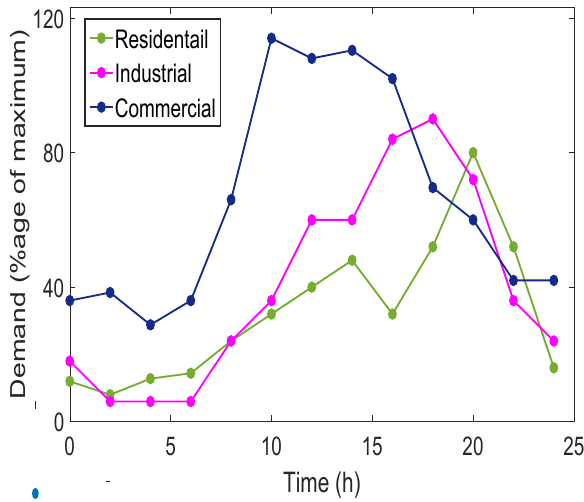
Figure 4. Daily load curves for different consumers like industrial, residential and commercial.